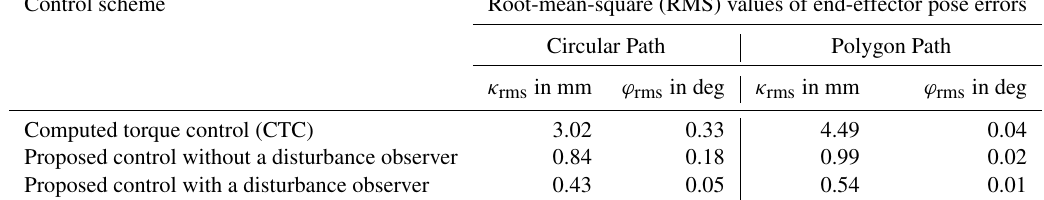
Table 4. Performance comparison of the controllers Control